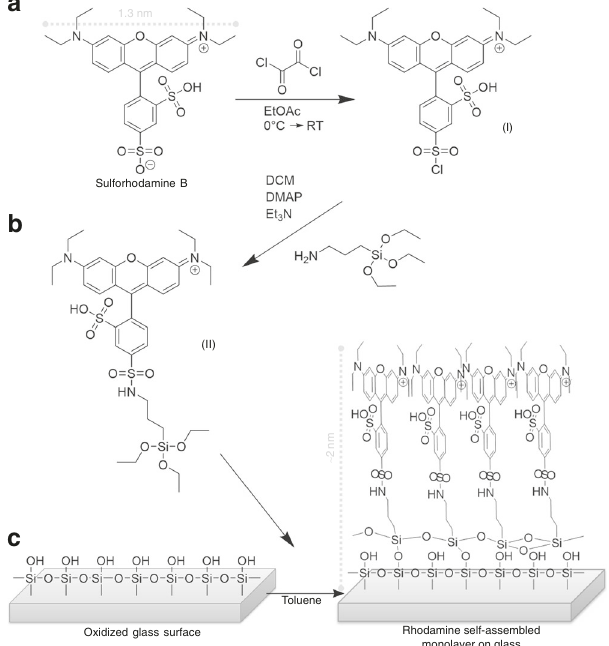
Fig. 8 Preparation and synthesis of SAMs of sulforhodamine B silane on glass. The preparation of a sulforhodamine B chloride and, subsequently, b sulforhodamine B silane, as well as c the fi nal formation of the SAM are illustrated (idealized